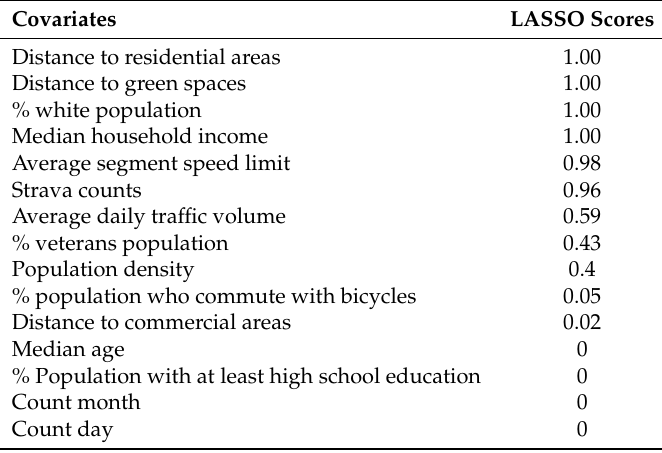
Table 2. Variable importance based on LASSO variable selection ( λ = 1.85).